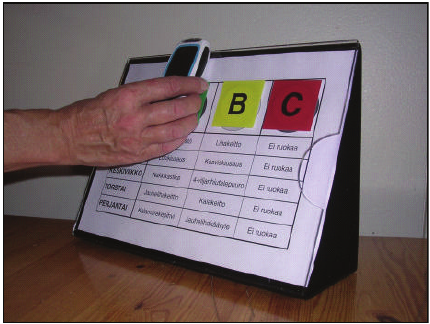
Figure 4: The meal order is placed by touching a tag with the mobile